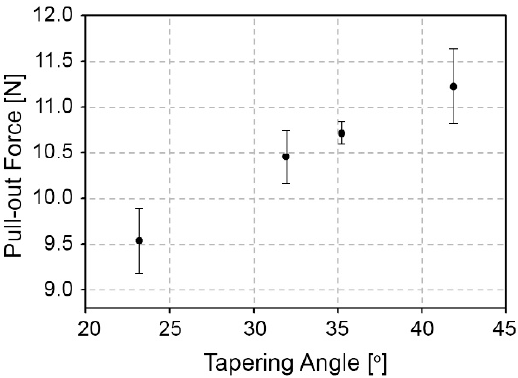
Figure 6. The measured pull-out forces are 9.54 ± 0.38 N, 10.45 ± 0.27 N, 10.72 ± 0.12 N, and 11.23 ± 0.44 N for tapering angles of 23.2 ° , 31.9 ° , 35.2 ° , and 41.8 ° , respectively.